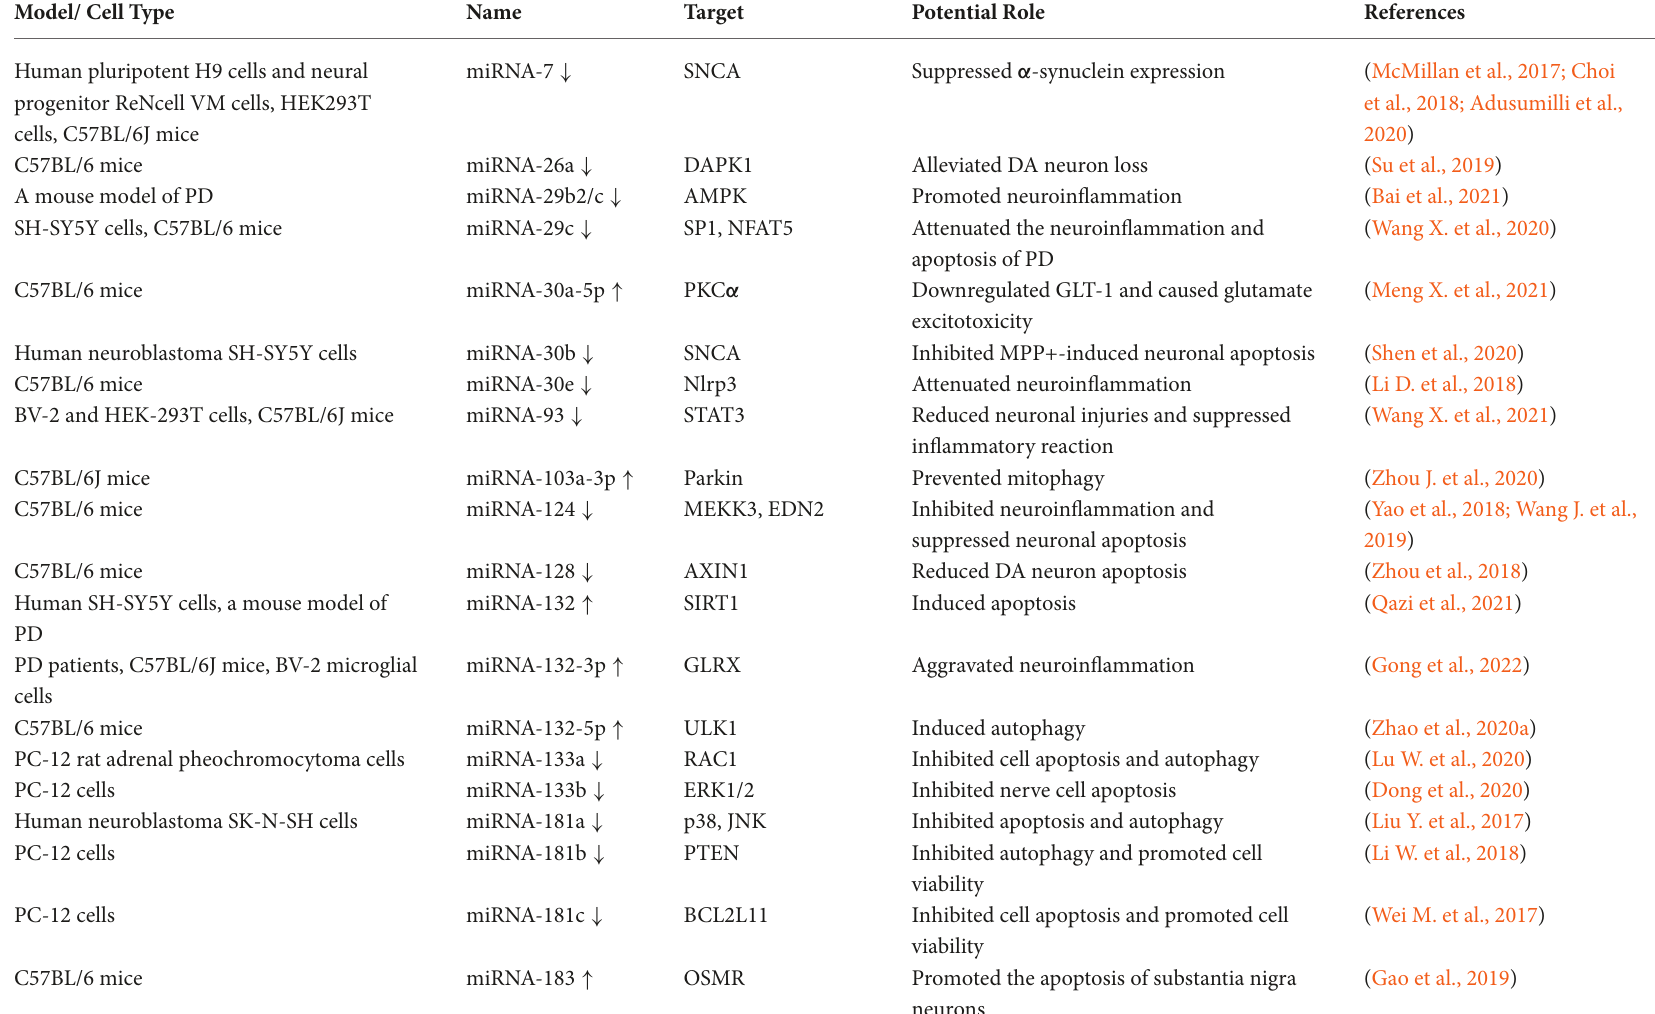
TABLE 1 Summary of regulatory non-coding RNAs that regulate Parkinson’s